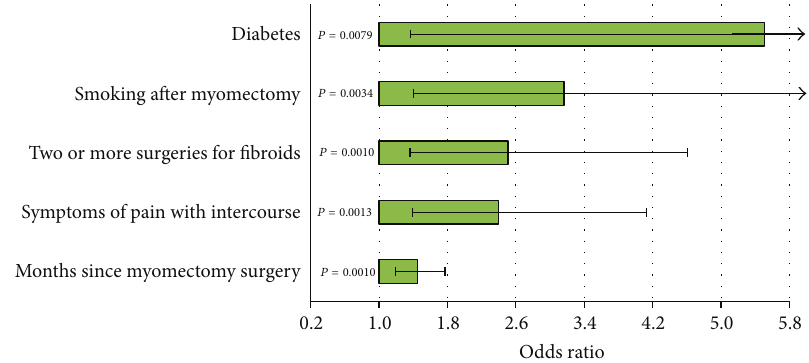
Figure 2: Factors independently associated with recurrence of symptoms. Shown are the factors that were statistically significant at 𝑃 < 0.05 in forward stepwise logistic regression.